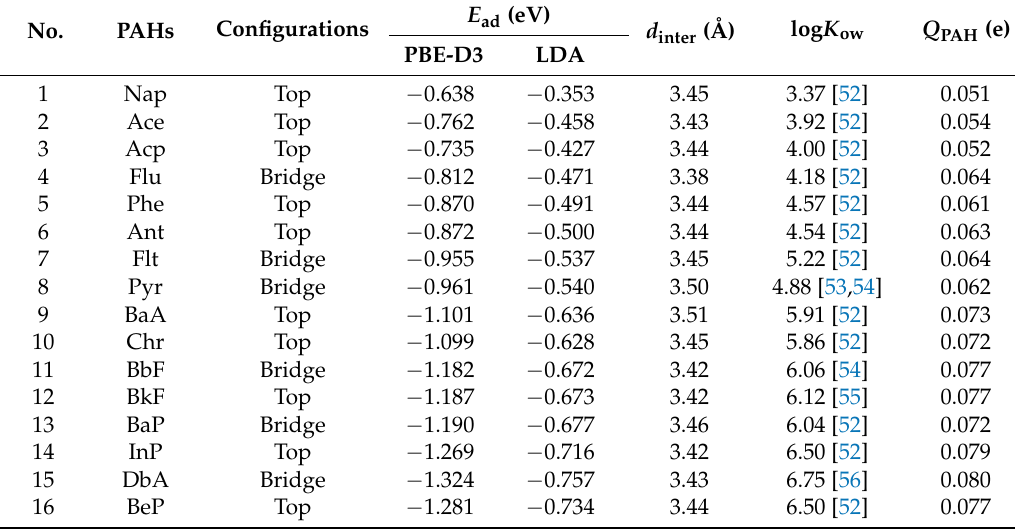
Table 2. Density function theory (DFT) calculations predicted parameters of PAHs adsorption onto Gr, including the most stable configuration, adsorption energies by PBE-D3 and LDA ( E ad ; in eV), equilibrium distance ( d inter ; in Å), the logarithm of the octanol/water partition coefficient from the experiments (log K ow ), as well as the charge transfer from Bader analysis ( Q PAH ; in e). Positive number of Q PAH indicates that the charge is transferred from PAH to